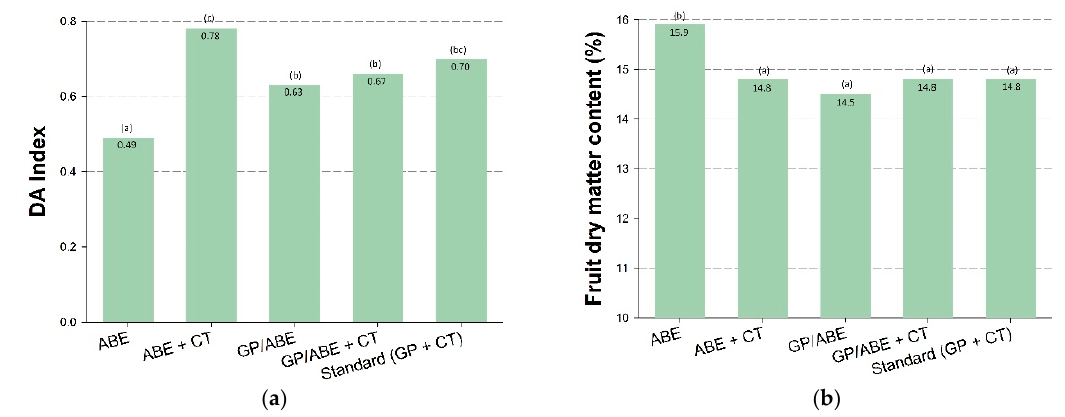
Figure 5. Effect of artificial bud extinction (ABE), pruning level and chemical thinning (CT) on ( a ) skin chlorophyll content (represented by DA Index) and ( b ) fruit dry matter content of ‘Buckeye Gala’. Letters above bars indicate mean separation at p = 0.05.